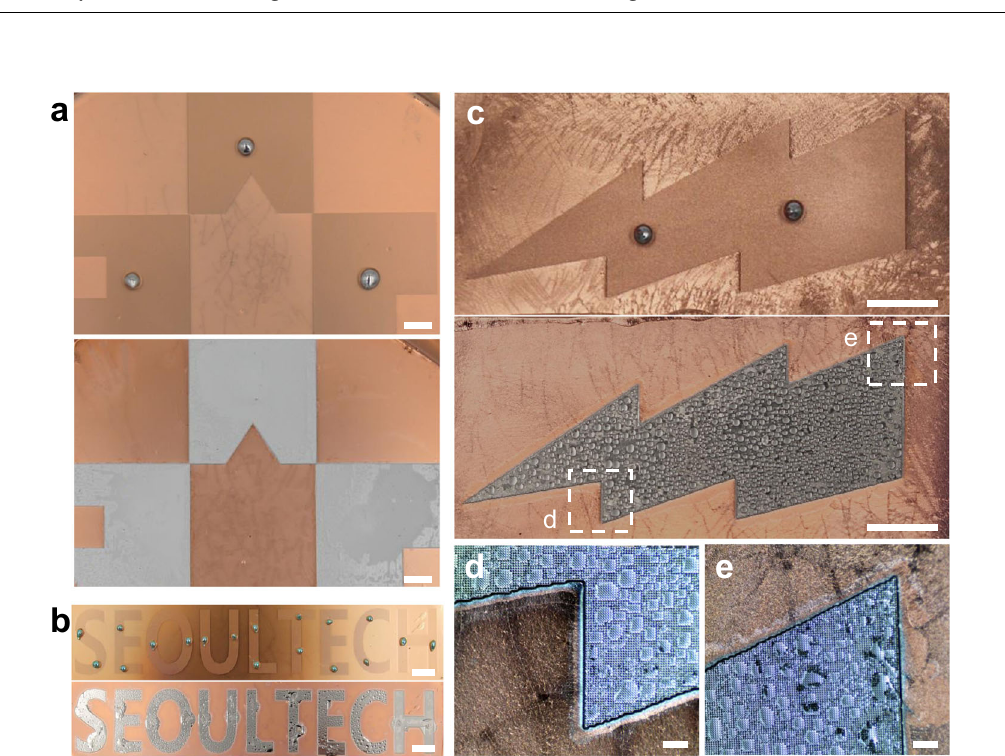
Fig. 4 | EGaIn patterning via imbibition-driven selective wetting. a University emblem, b letters, and c lightning shape. Regions for imbibition are covered with the arrays of posts with D = l =25 μ m. d , e Enlarged images of edges in ( c ). The scale bars in ( a – c ) and ( d , e ) are 5mm and 500 μ m, respectively. In ( c – e ),